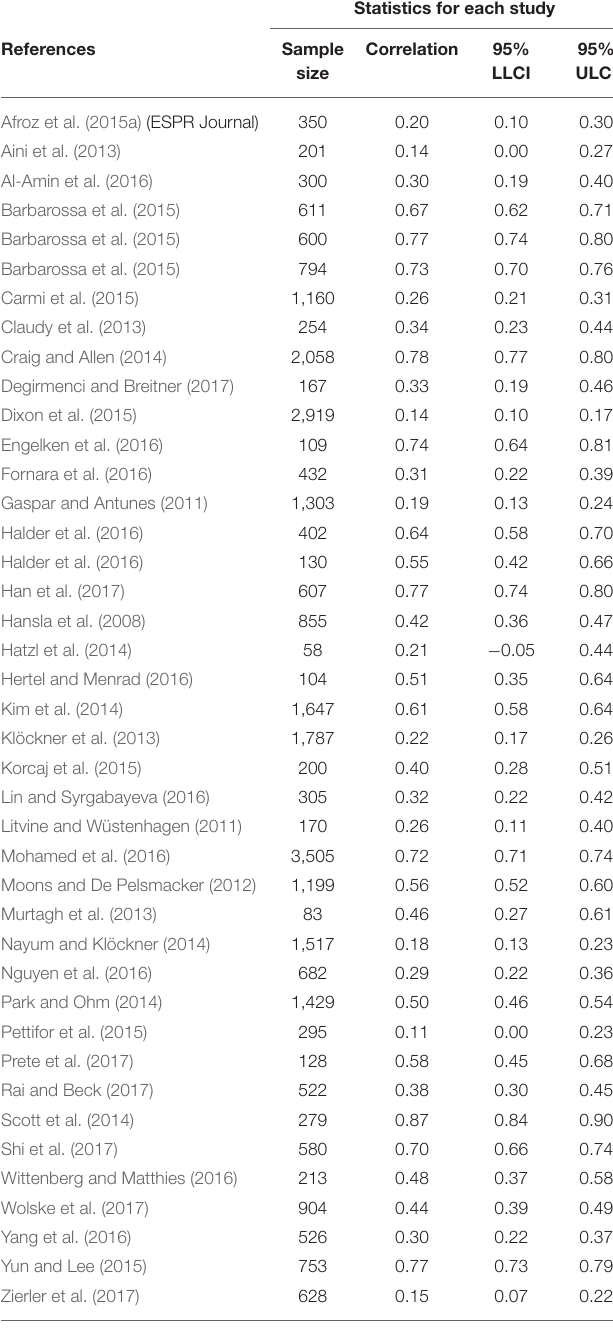
Statistics for each